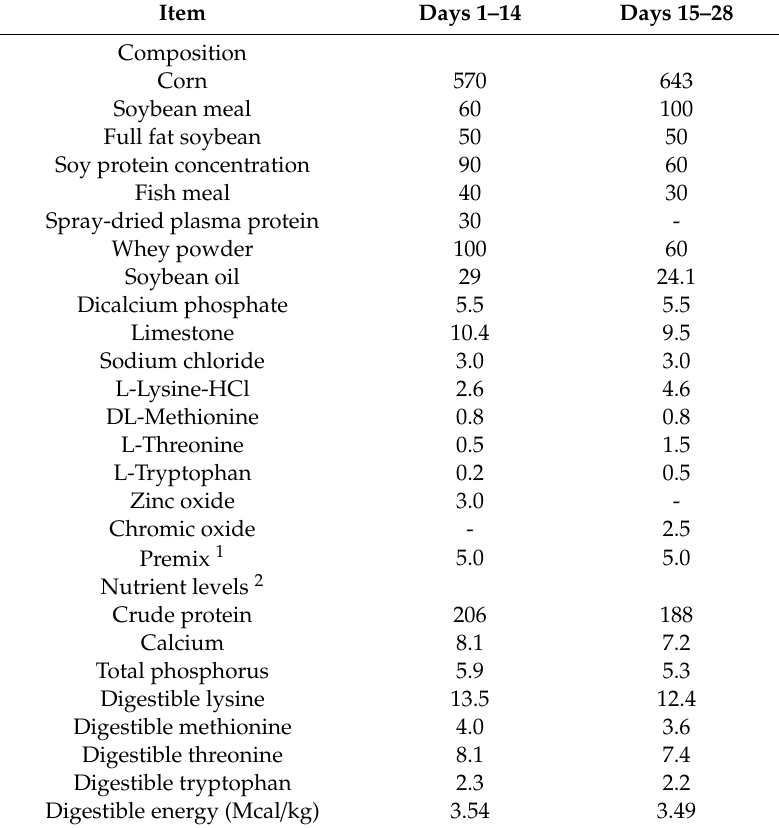
Table 1. Composition and nutrient levels of basal diets (g / kg,